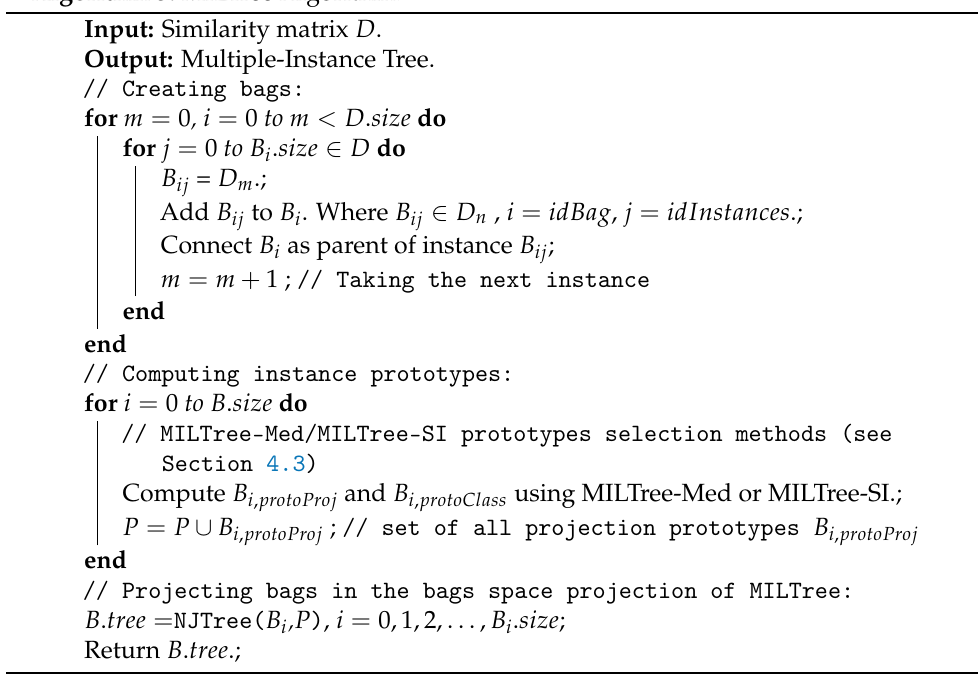
Algorithm 3: MILTree